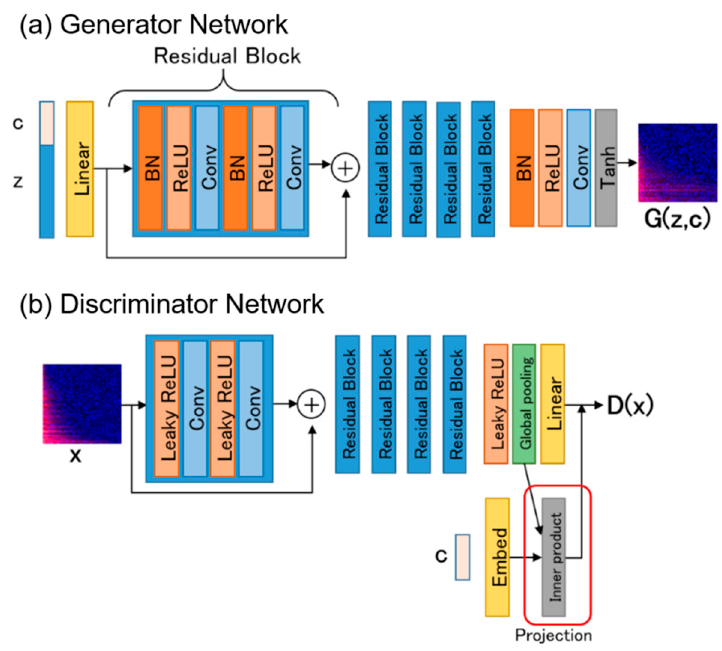
Figure 11. Proposed architecture of GAN. ( a ) generator network, ( b ) discriminator network.